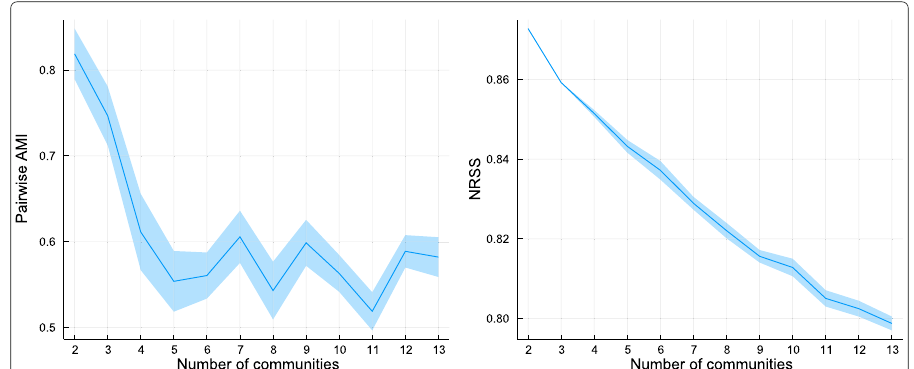
Fig. 12 Elm community activity. Relative activity of each community in each month. The communities are named by important packages as detailed in the Methods